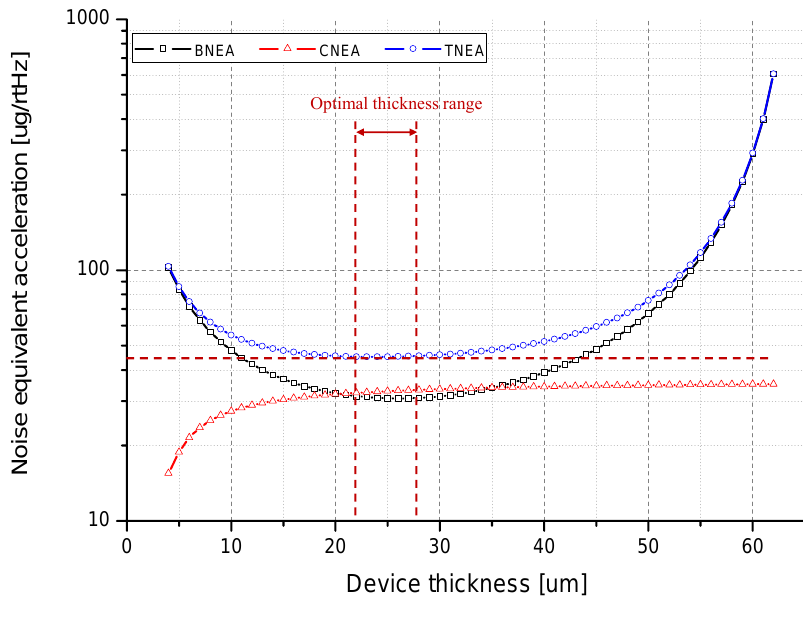
Figure 6. Noise Equivalent Acceleration vs. device